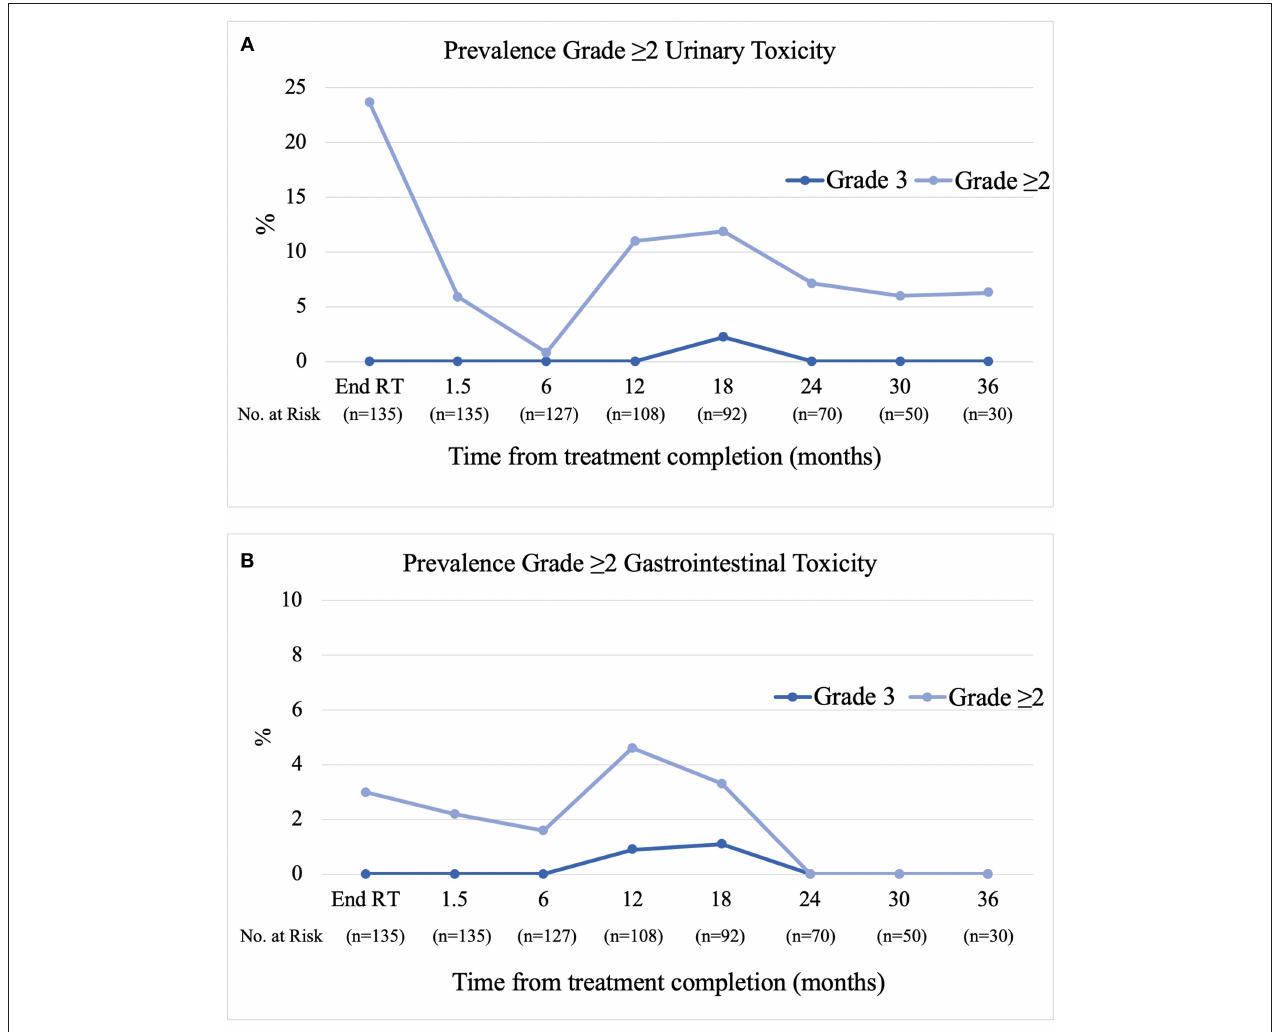
FIGURE 2 | Prevalence of CTCAE v4 Grade ≥ 2 Urinary (A) and Gastrointestinal (B) Toxicity.